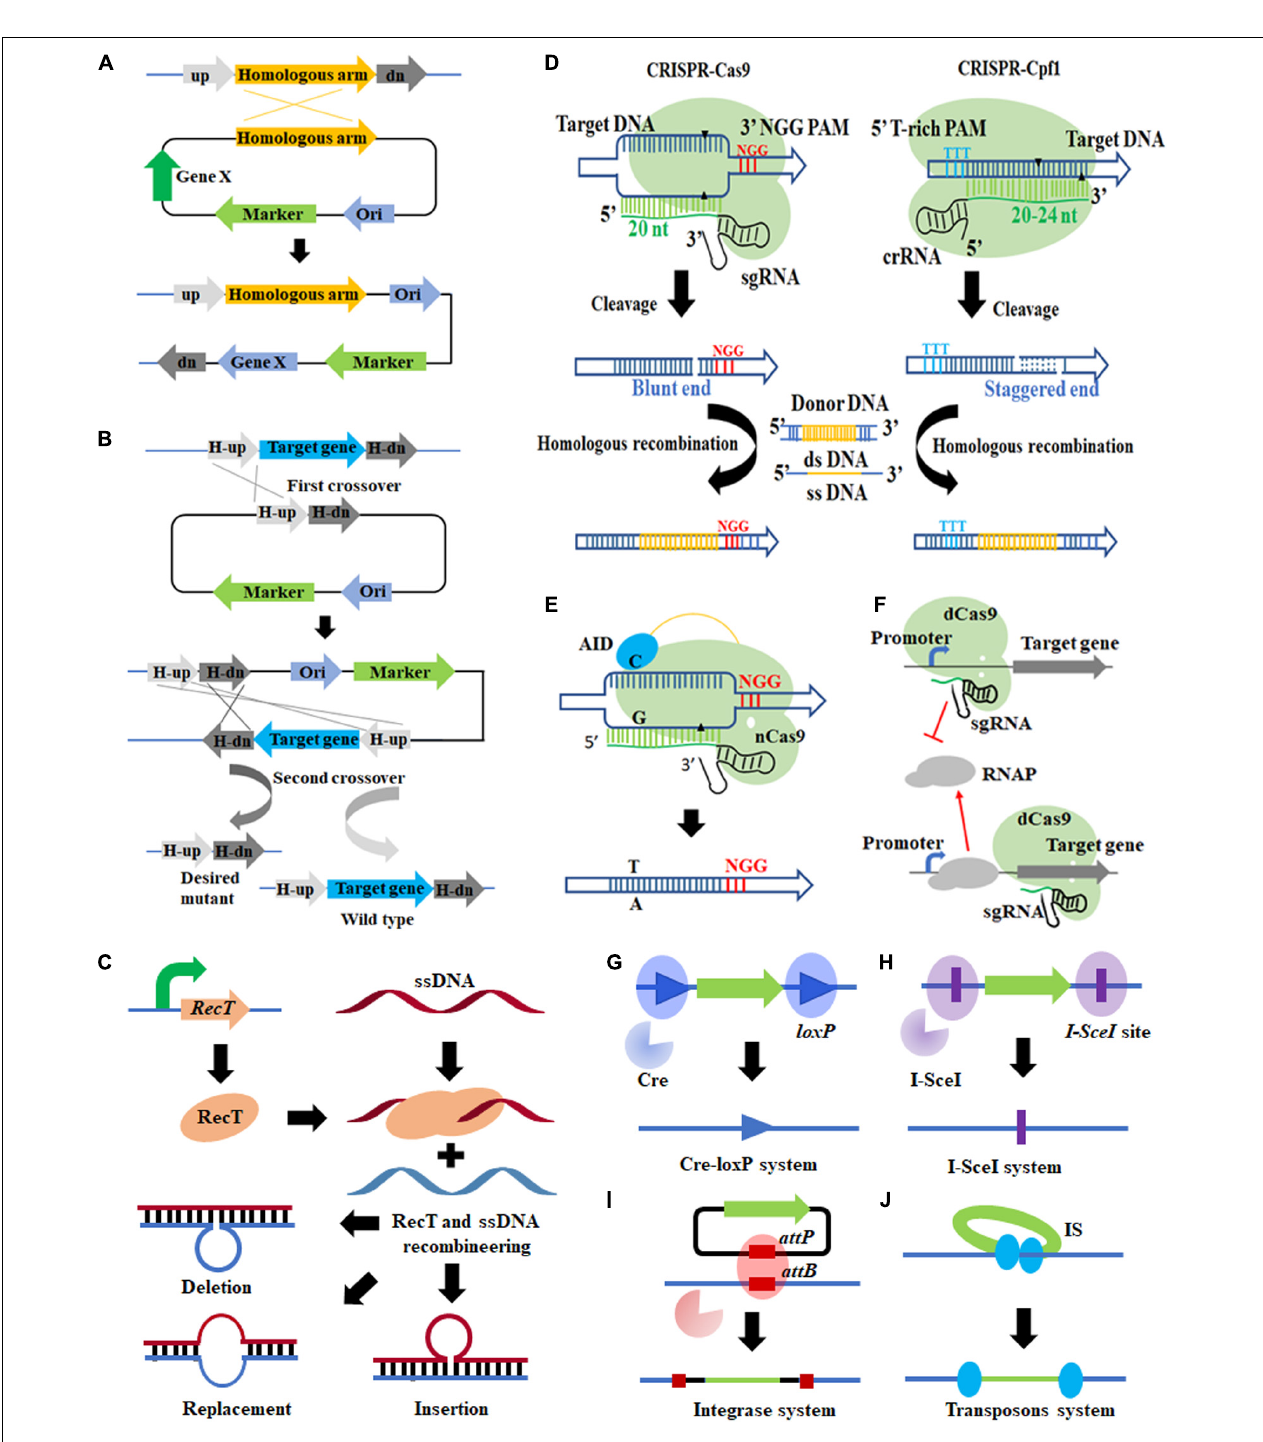
FIGURE 1 | Genome editing tools applicable in Corynebacterium glutamicum. (A,B) Allelic exchange-based tools (single and double crossover); (C) RecT-ssDNA-mediated recombination; (D) CRISPR/Cas system; (E) CRISPR/Cas system-assisted base editing system; (F) CRISPR/Cas system-assisted transcription regulation; (G) Cre-loxP system; (H) I-SceI system; (I) integrase-mediated site-specific integration; (J) transposon.